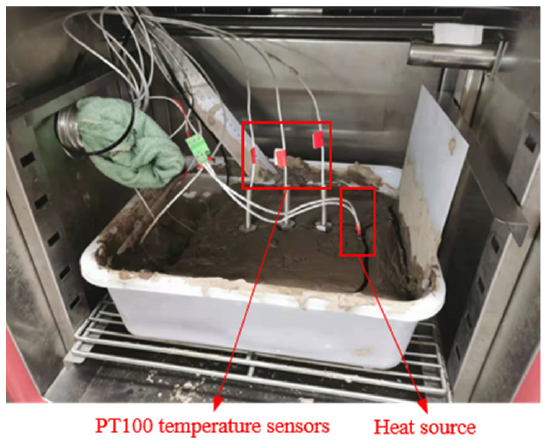
Figure 2. Experimental photo of the thermal conductivity measurement.